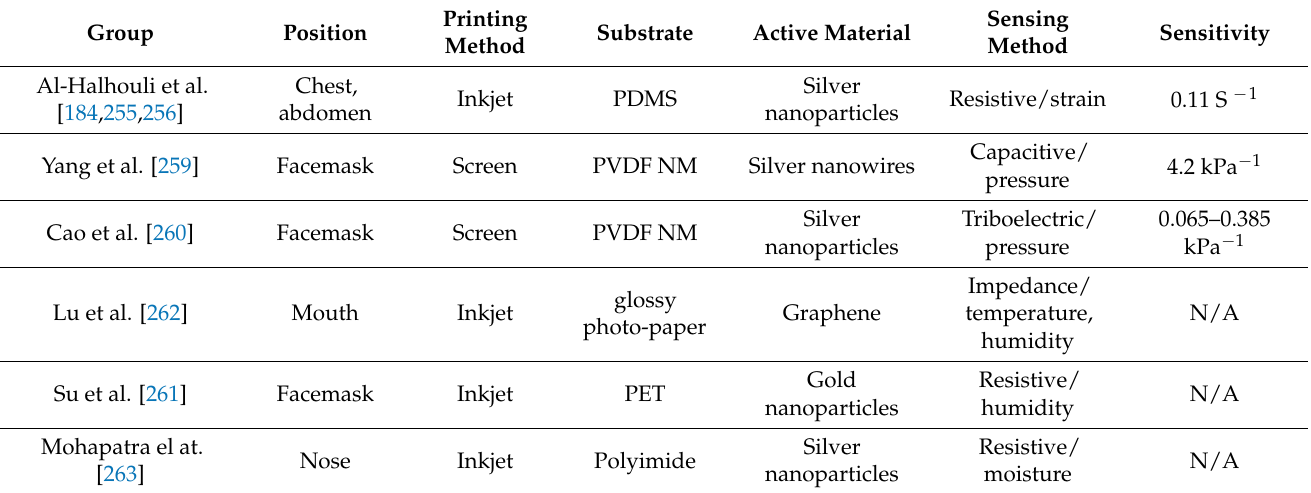
Table 3. A review of printed respiratory rate